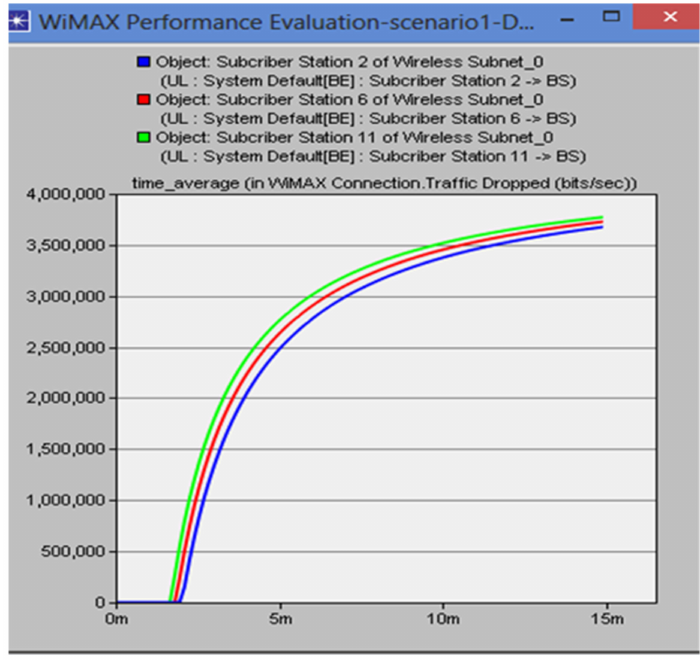
Figure 7. Traffic